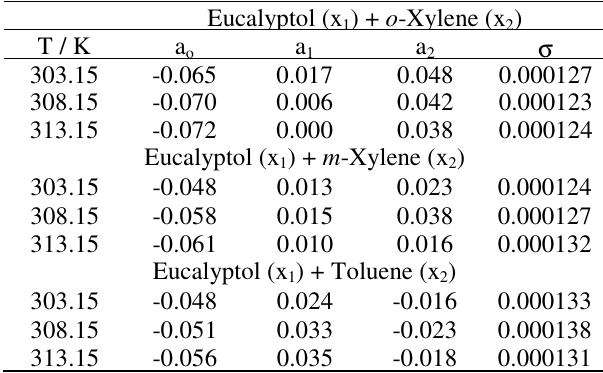
Table 2. Parameters, a and standard deviation, σ for Eucalyptol + Hydrocarbon i binary liquid mixtures at 303.15 K, 308.15K and 313.15 K for n